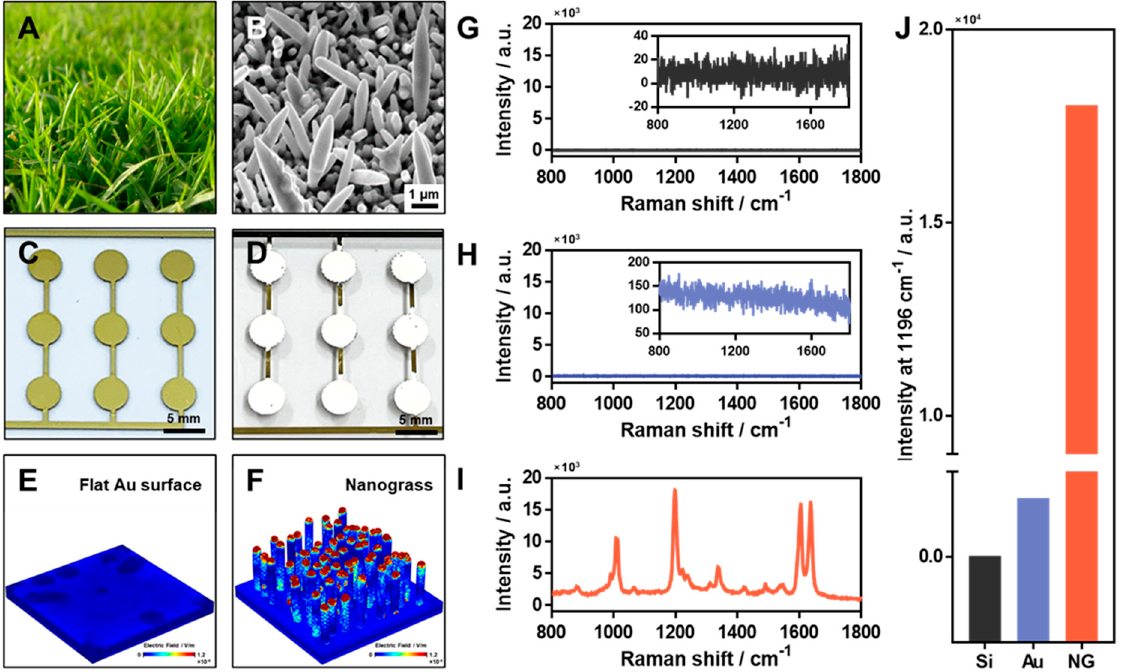
Figure 1. Bio-inspired Ag-NG as a sensitive surface-enhanced Raman spectroscopy (SERS) substrate. Optical and SEM images of ( A ) a lawn and ( B ) Ag-NG (scale bar: 1 µ m). Optical images of a ( C ) flat Au substrate and ( D ) Ag-NG fabricated substrate (scale: bar: 5 mm). FEM-based electromagnetic simulation results for ( E ) a flat Au surface and ( F ) Ag-NG (color bar: ~0–1.2 × 10 − 4 V/m). SERS spectra of bisphenol E (BPe, 1 mM) for different substrates: ( G ) Si glass, ( H ) flat Au surface, and ( I ) Ag-NG. The insets in ( G , H ) are magnified spectra of BPe for the respective substrates. ( J ) Comparison of SERS intensity of a BPe main peak (1196 cm − 1 ) for different substrates (Si: slide glass, Au: flat gold substrate, and NG: Ag-NG).